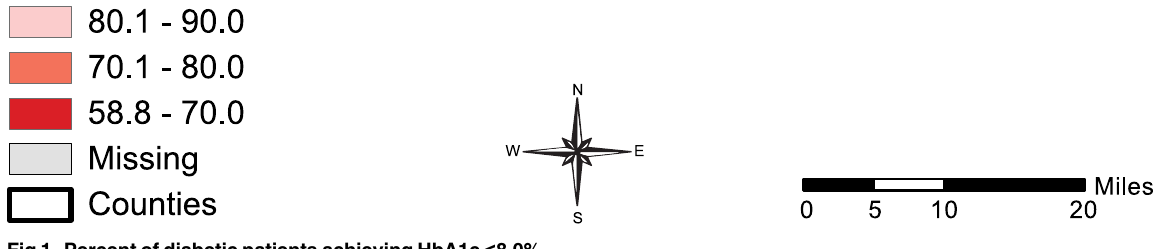
PLOS ONE | DOI:10.1371/journal.pone.0159227 July 27,